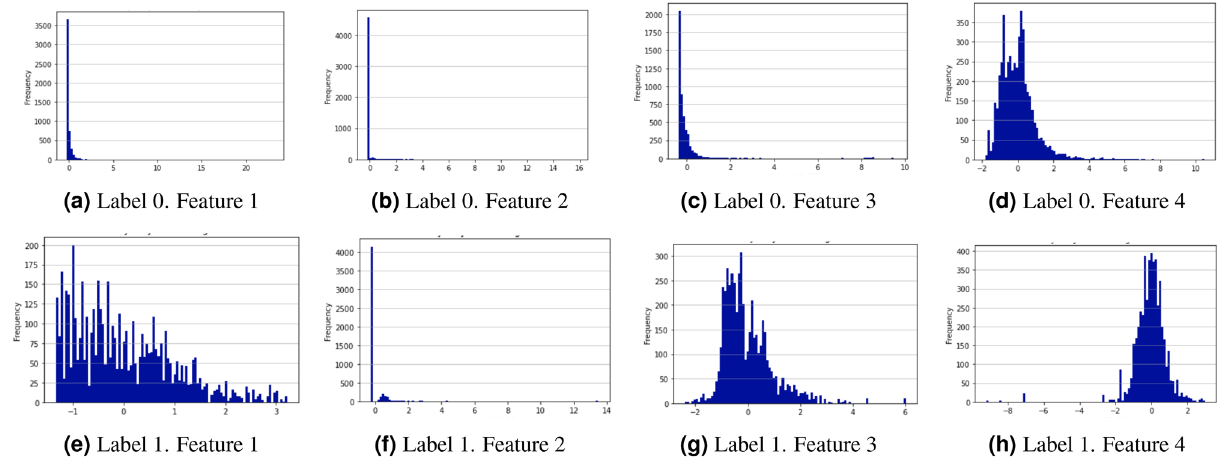
Figure 2. Frequency distribution histogram of the 4 variables extracted from normal (Label 0) and cryptomining (label 1) traffic. Label 0 ( a – d ) and label 1 ( e – h